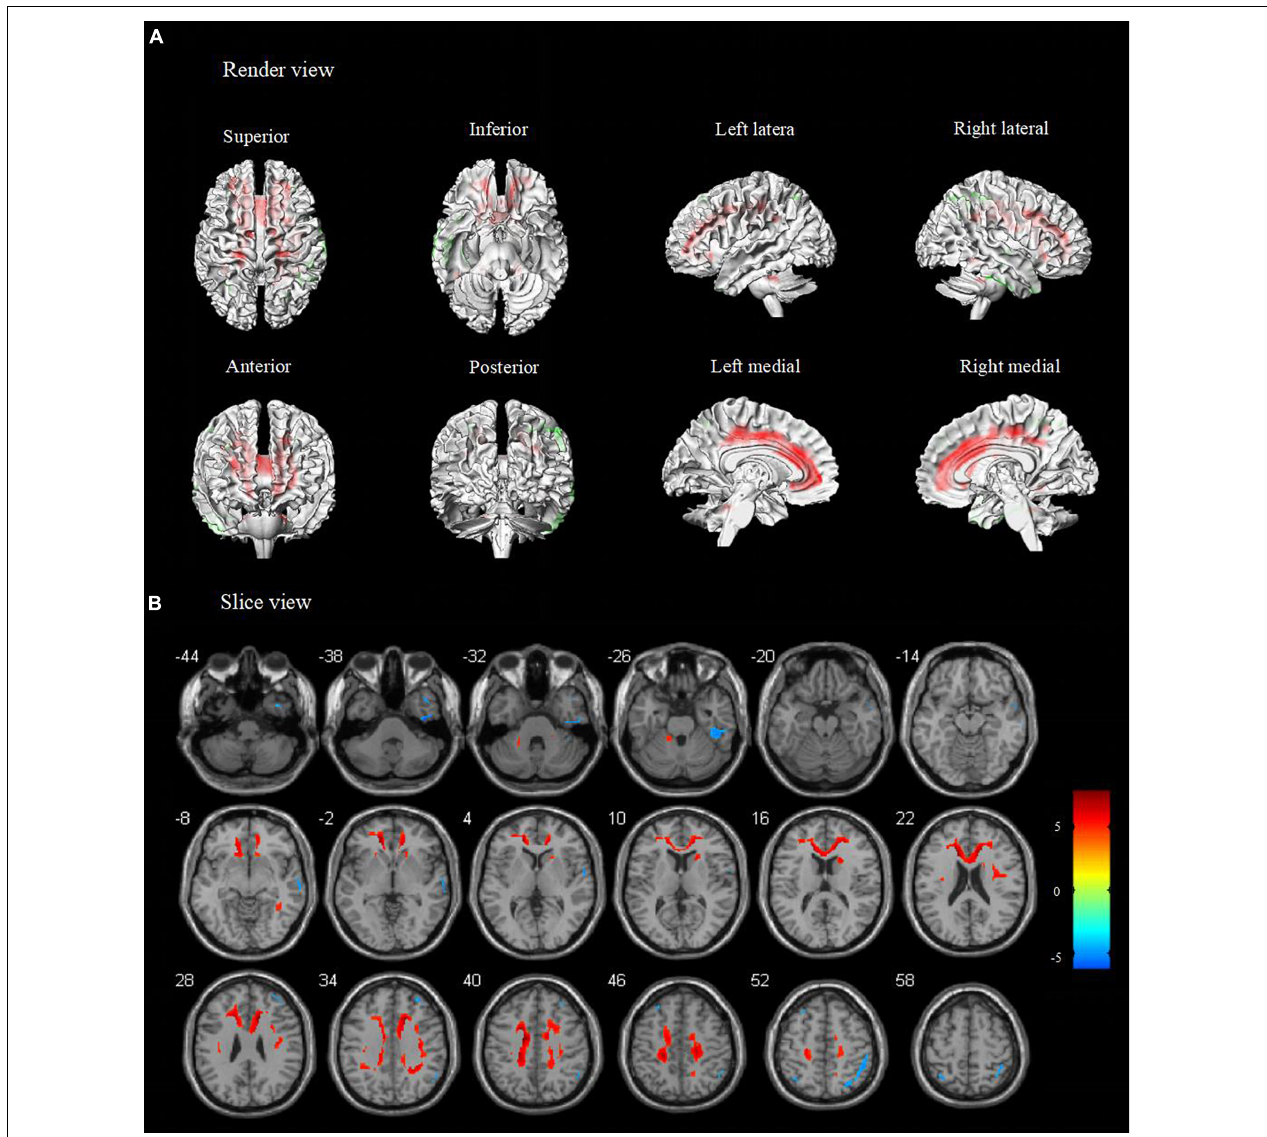
FIGURE 1 | Metabolic features in temporal lobe epilepsy with impaired awareness seizures (FWE corrected). Comparison of temporal lobe epilepsy with awareness impairing seizures ( N = 76) versus healthy controls ( N = 60) was performed in (A) render view and (B) slice view (FWE corrected p < 0.05 with cluster thresholding, k = 20 voxels). Voxels with significantly low uptake are shown in green and voxels with significantly high uptake are shown in